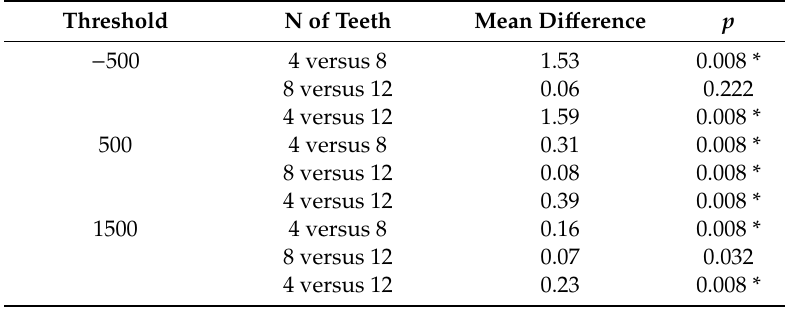
Table 3. Pairwise comparison of registration error between di ff erent numbers of remaining teeth using the post hoc Mann–Whitney U test. * Significant di ff erence ( p < 0.0166, Bonferroni